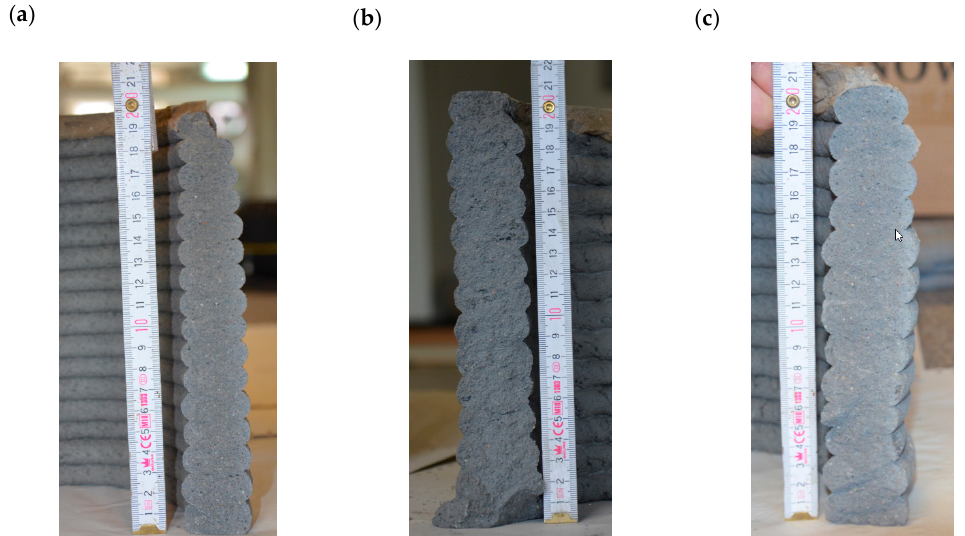
Figure 21. Cross sections of printed column: ( a ) B840/SF/FA/LP; ( b ) B640/SF/FA/LP; ( c ) B640/SF/FA.